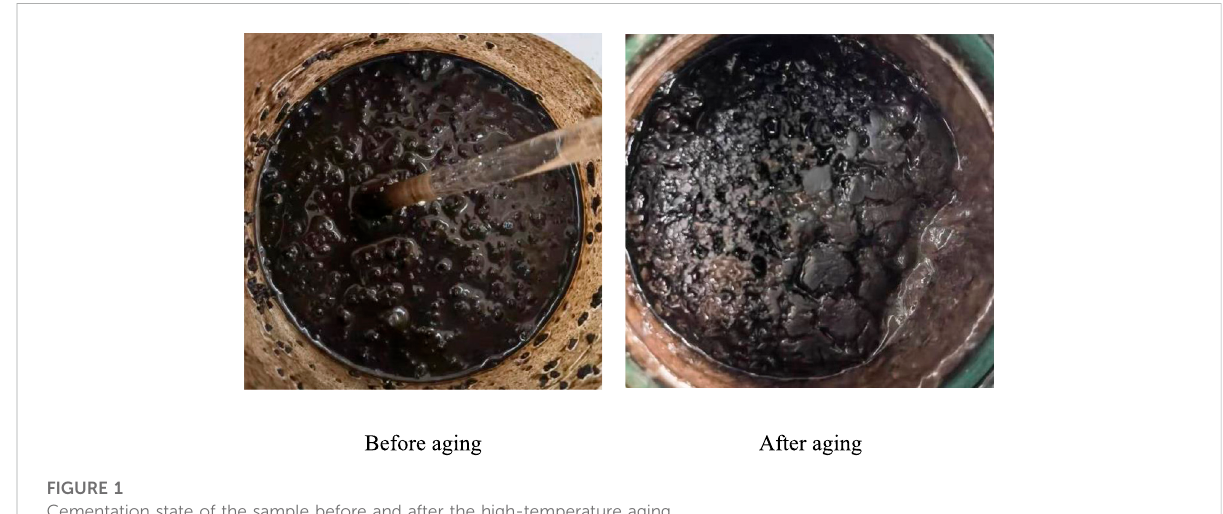
FIGURE 1 Cementation state of the sample before and after the high-temperature